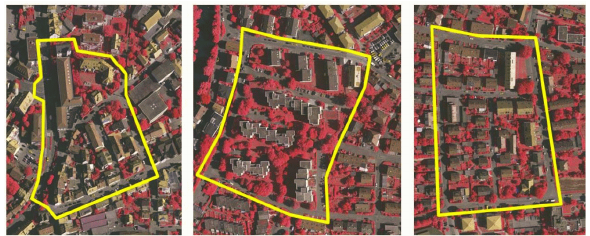
Figure 1: Test sites of scene Vaihingen. ’Inner City’ (Area 1, left), ’High-Riser’ (Area 2, middle) and ’Residental’ (Area 3, right) (Rottensteiner et al.,